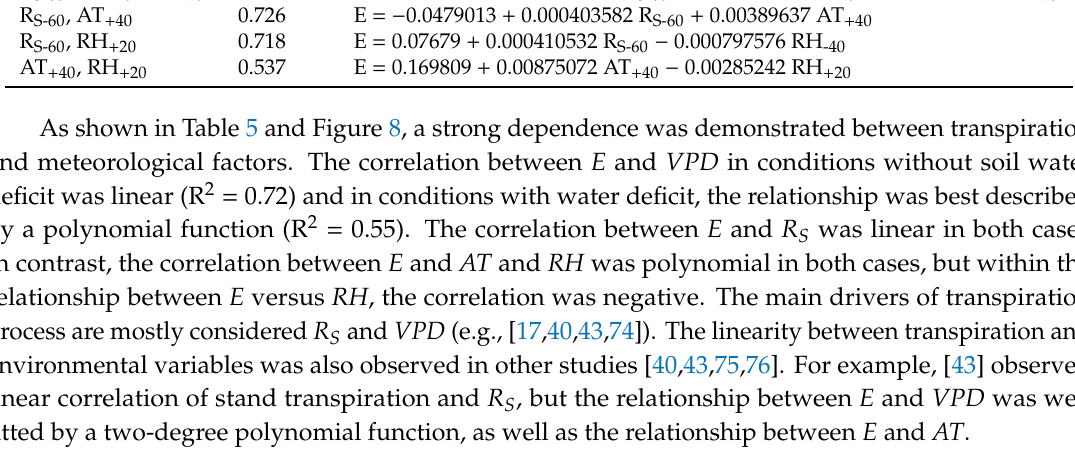
Table 5. Regression analysis of stand transpiration and environmental variables shifted in time for 2 categories of soil water conditions: without water deficit versus water deficit.